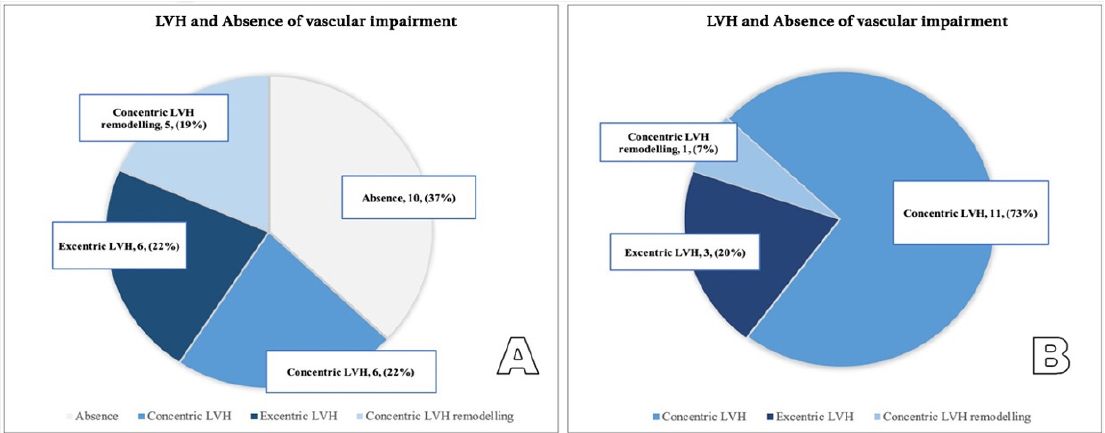
Figure 7. ( A , B ) Correlation between LVH type in patients without vascular impairment ( A ) and patients with vascular impairment ( B ).